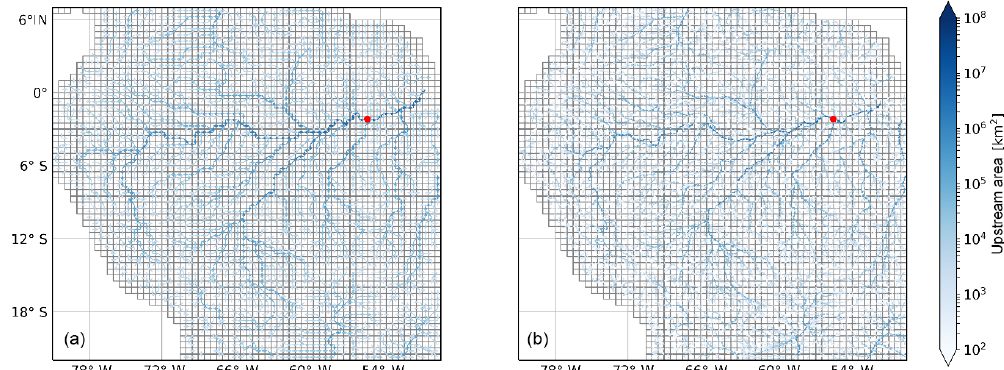
Figure 2. The PCR drainage network (LDD) of the Amazon River basin at 30arcmin spatial resolution (a) as well as the 1-D channel network of CMF (b) . The upstream area of the drainage network is shown in shades of blue and the location of the Óbidos gauge in red.